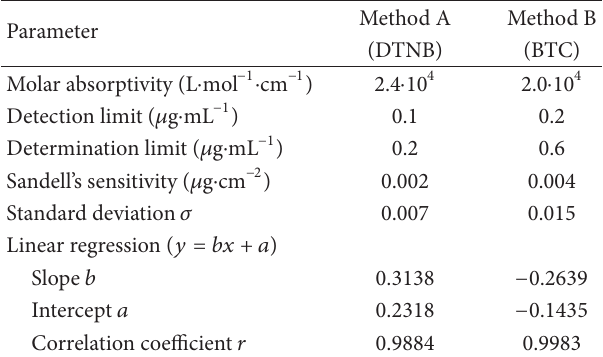
determination (in the absorbed 2